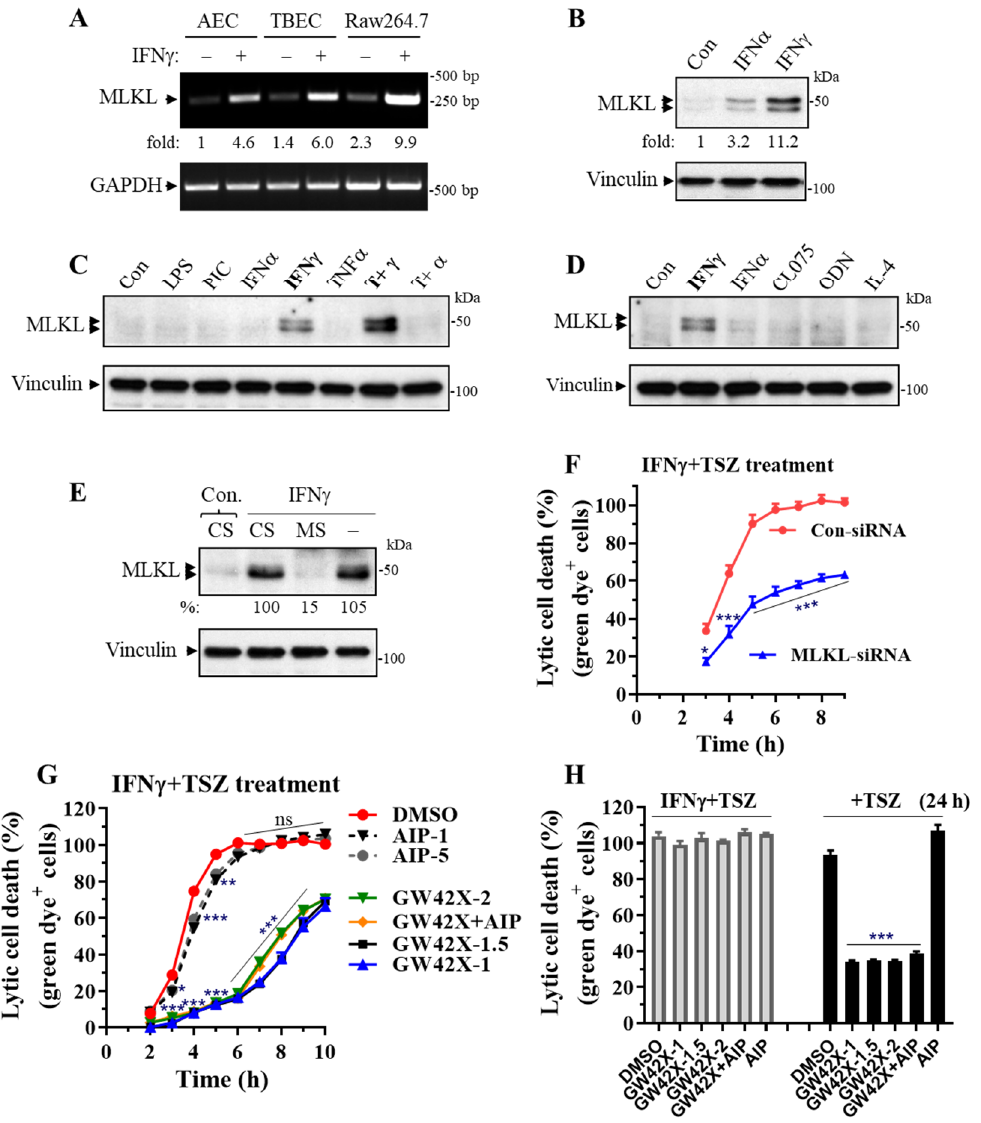
Figure 6. MLKL is predominantly induced by IFN γ in primary lung epithelial cells, and MLKL silencing or inhibition largely suppresses the IFN γ -promoted necroptosis. ( A ) RT-PCR showing the induction of MLKL by IFN γ . Mouse primary AECs and TBECs or Raw264.7 macrophages were treated with IFN γ (50 ng/mL) for 24 h, and mRNA levels of MLKL and GAPDH are shown in a representative RT-PCR. ( B – D ) Western blots showing the expression of MLKL. Primary mouse AECs were incubated with control PBS (Con.), IFN α 2 (50 ng/mL), IFN γ (50 ng/mL), LPS (100 ng/mL), poly(I:C) (PIC, 0.5 µ g/mL), TNF α (25 ng/mL), TNF α (25 ng/mL) plus IFN γ (50 ng/mL) (T+ γ ), TNF α (25 ng/mL) plus IFN α (50 ng/mL) (T+ α ), CL075 (1 µ g/mL), ODN1585 (1 µ M) or IL-4 (15 ng/mL) for 24 h. Equal amounts of cell lysates were subjected to Western blot analysis. Results represent the findings of 3 independent experiments. ( E ) MLKL knockdown by siRNA. Primary mouse AECs were transfected with 20 nM control siRNA (CS) or MLKL siRNA (MS) for 6 h, then treated with control PBS (Con) or IFN γ (25 ng/mL) for 24 h. Equal amounts of cell lysates were subjected to Western blots. Results represent the findings of 3 independent experiments. ( F ) MLKL silencing largely suppresses the IFN γ -promoted necroptosis. Primary mouse AECs were transfected with control siRNA or MLKL siRNA for 6 h, incubated with IFN γ (25 ng/mL) for 24 h, then subjected to TSZ-induced real-time necroptosis assay as described in Figure 2. * p < 0.05; ** p < 0.01; *** p < 0.001 versus control siRNA in each time point (n = 4). ( G , H ) Effects of MLKL or CaMKII inhibitors on necroptosis. Mouse AECs were incubated without or with IFN γ (25 ng/mL) for 24 h, then subjected to TSZ-induced real-time necroptosis assay as described above in the presence of DMSO,